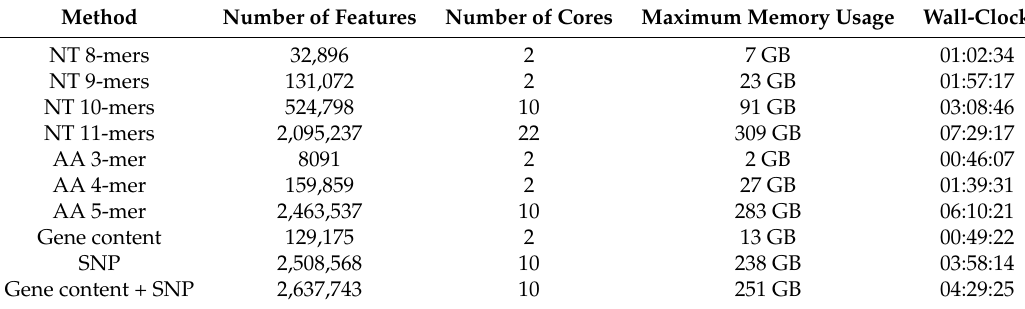
Table A69. Resources for K. pneumoniae